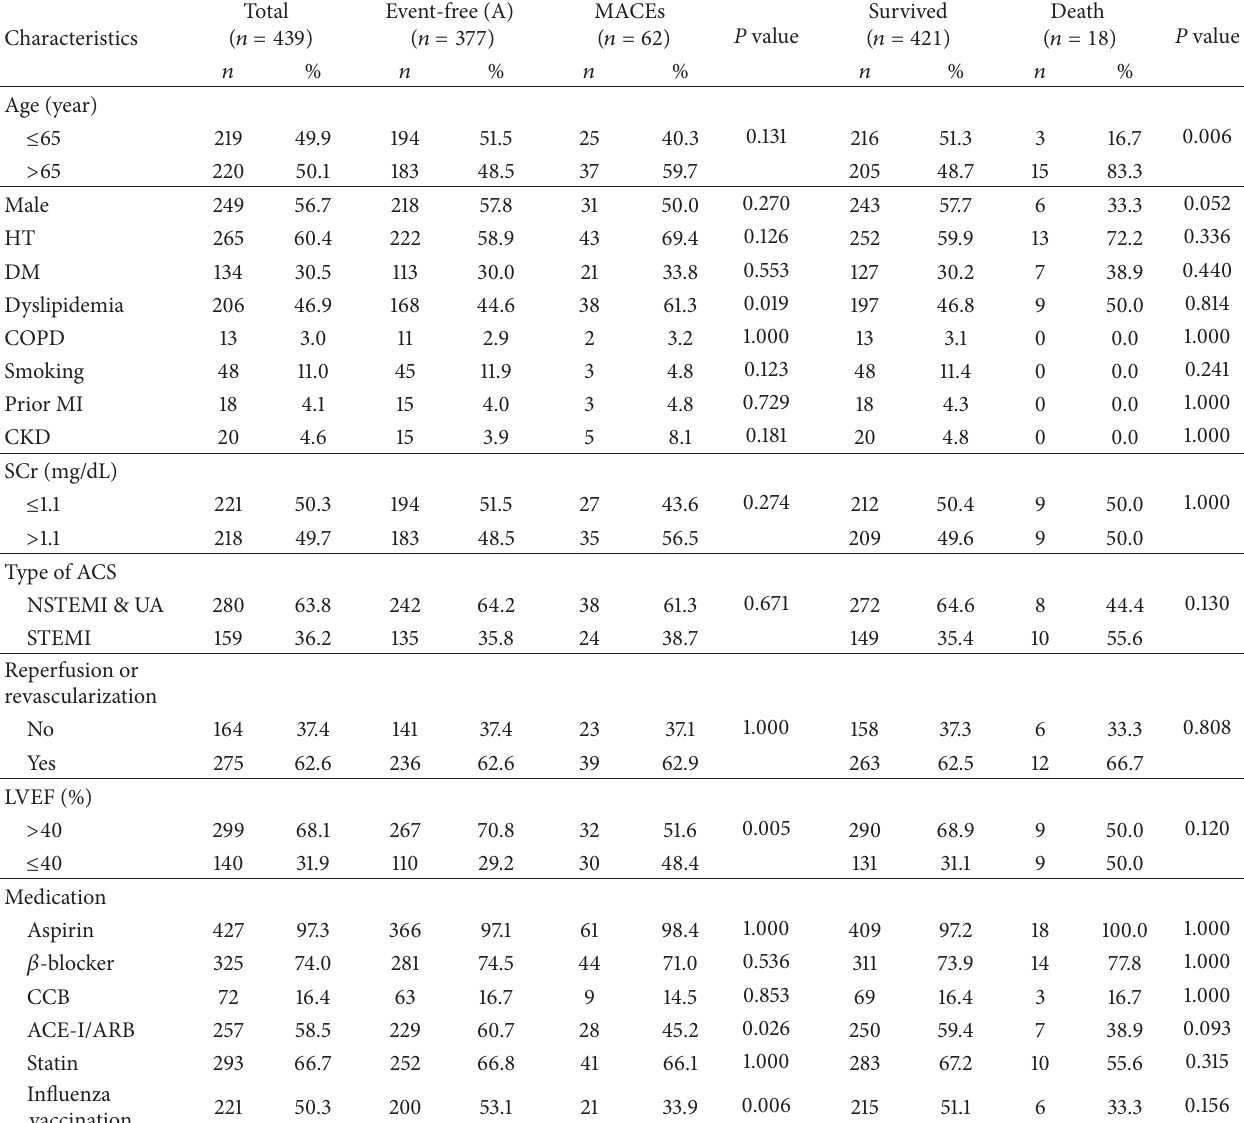
Table 1: Patients’ characteristics for MACEs and